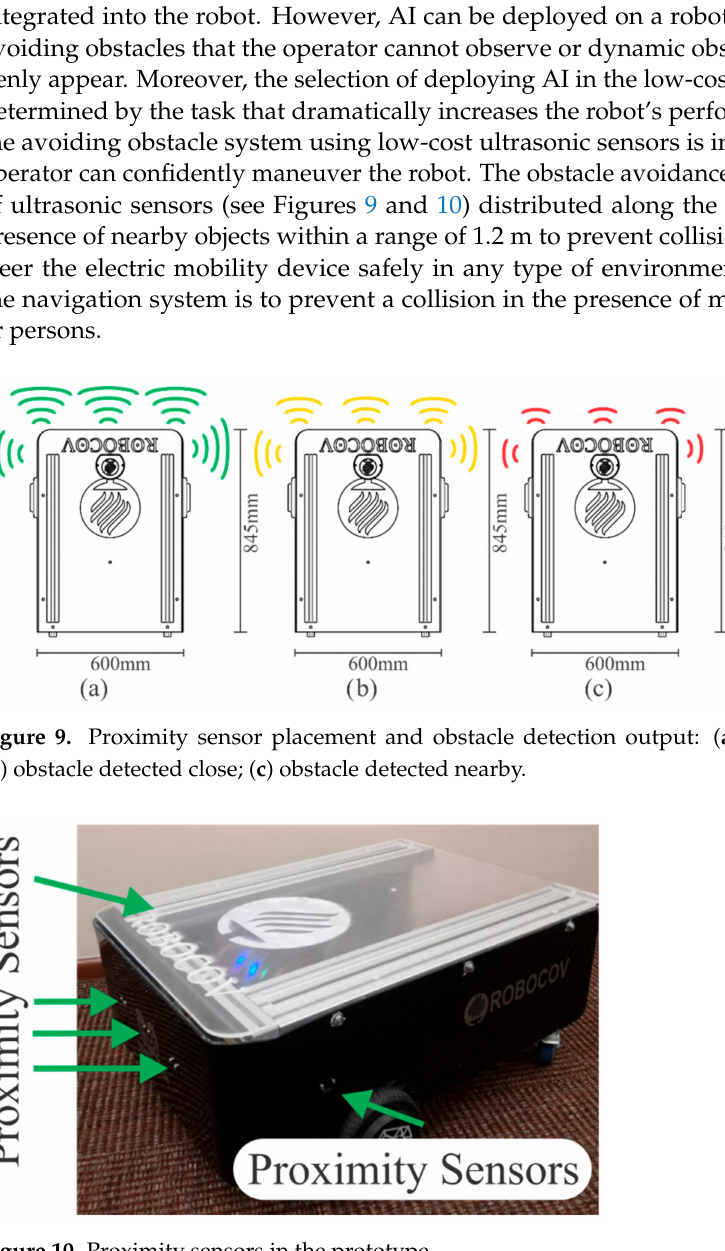
Figure 10. Proximity sensors in the